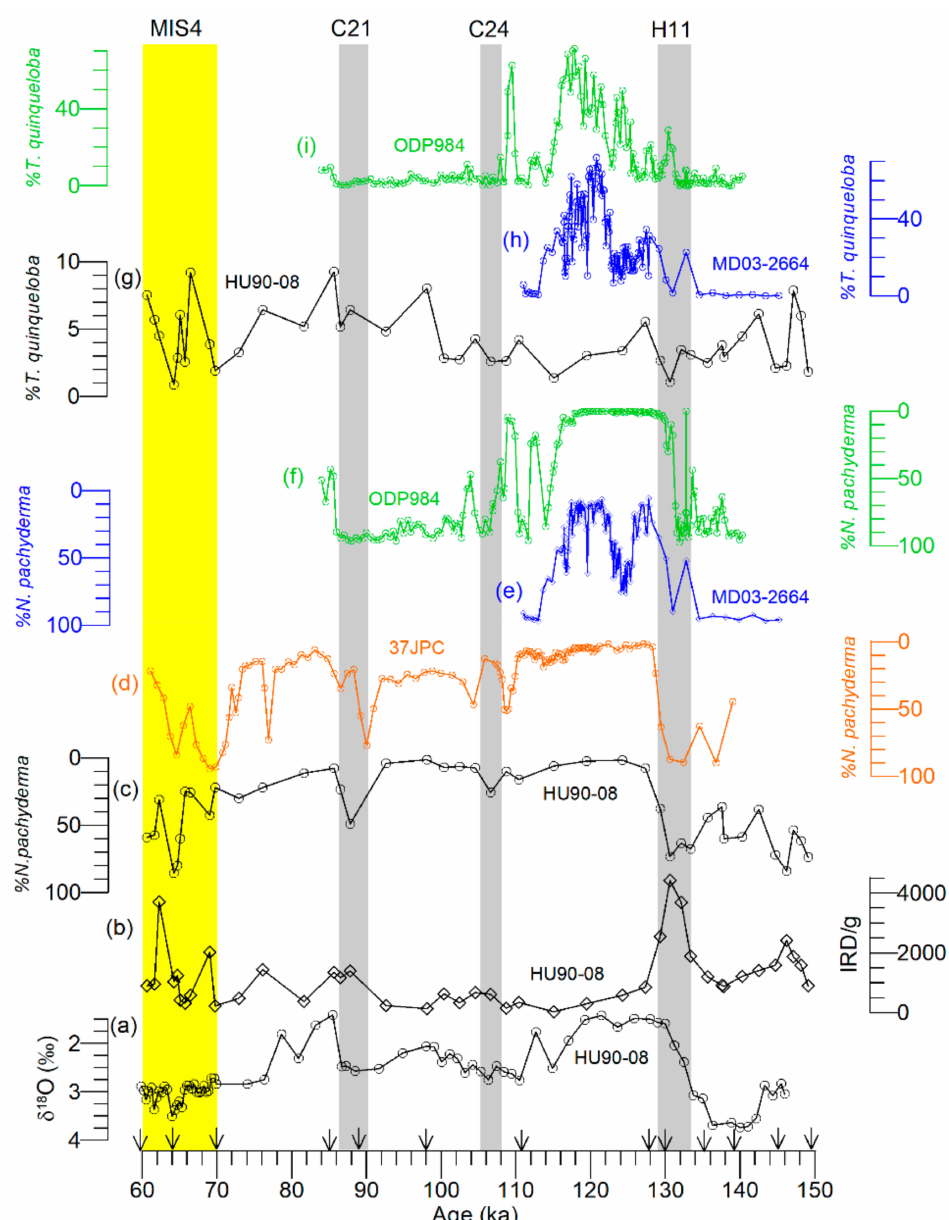
Figure 6. Paleo-proxy records of changes ( a – i ) in the sea-surface characteristics of the subpolar North Atlantic between 60 and 150 ka. Downward simple-headed triangles exhibit the tie points used to construct the age model of core Hu90-08 (this study). The vertical discontinuous line represents termination II (TII). Hx = Heinrich events; Cx = Cooling